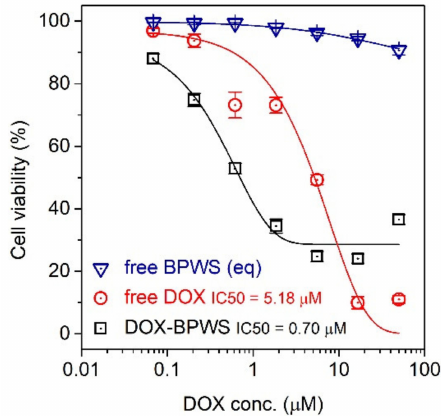
Figure 5. A plot of cell viability versus DOX concentration for 3-(4,5-dimethylthiazol-2-yl)-2,5- diphenyltetrazolium bromide (MTT) assays of MCF-7 Cells with doxorubicin, DOX-loaded BPWS and free BPWS as well as the IC 50 after 72